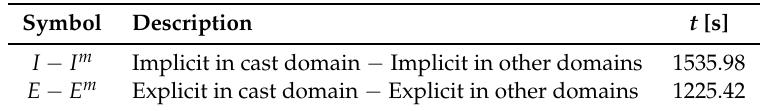
Table 4. A total time t of computations obtained for the sub-cycles methods ( m = 15). The same integration methods and the different time step.